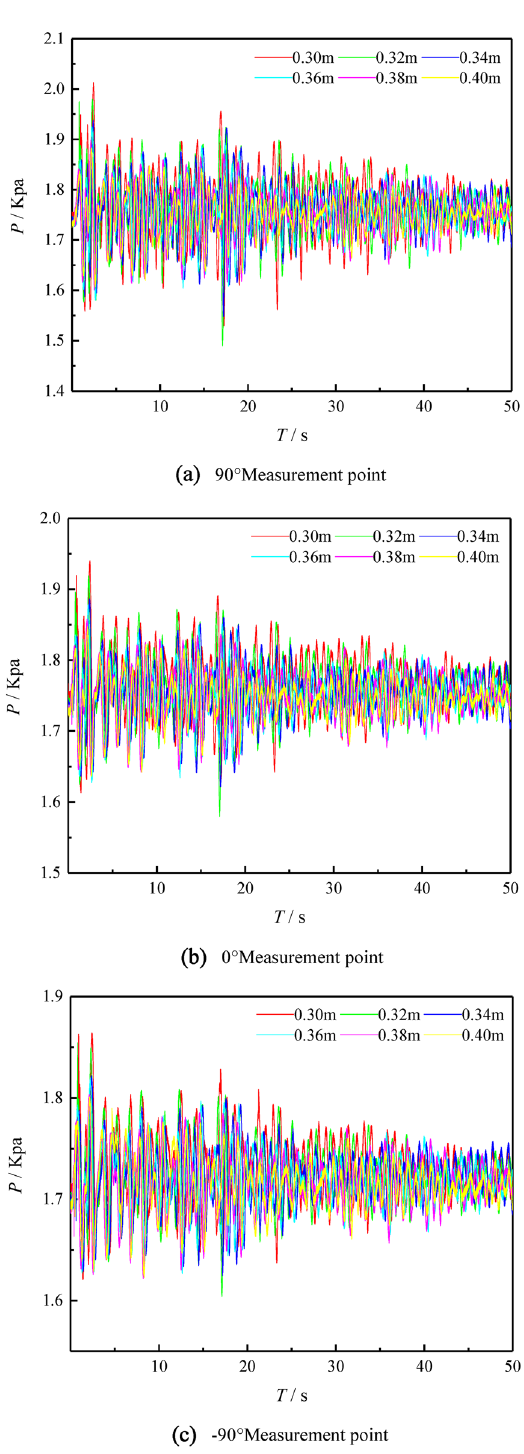
Figure 6. Pressure fluctuation curves at 90°, 0° and − 90° measuring points ( a ) 90° measurement point ( b ) 0° measurement point ( c ) − 90° measurement